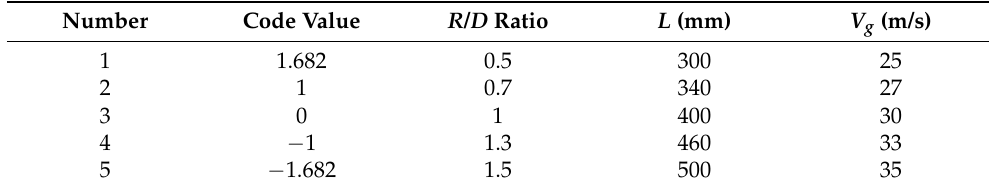
Table 3. Simulation parameters of different